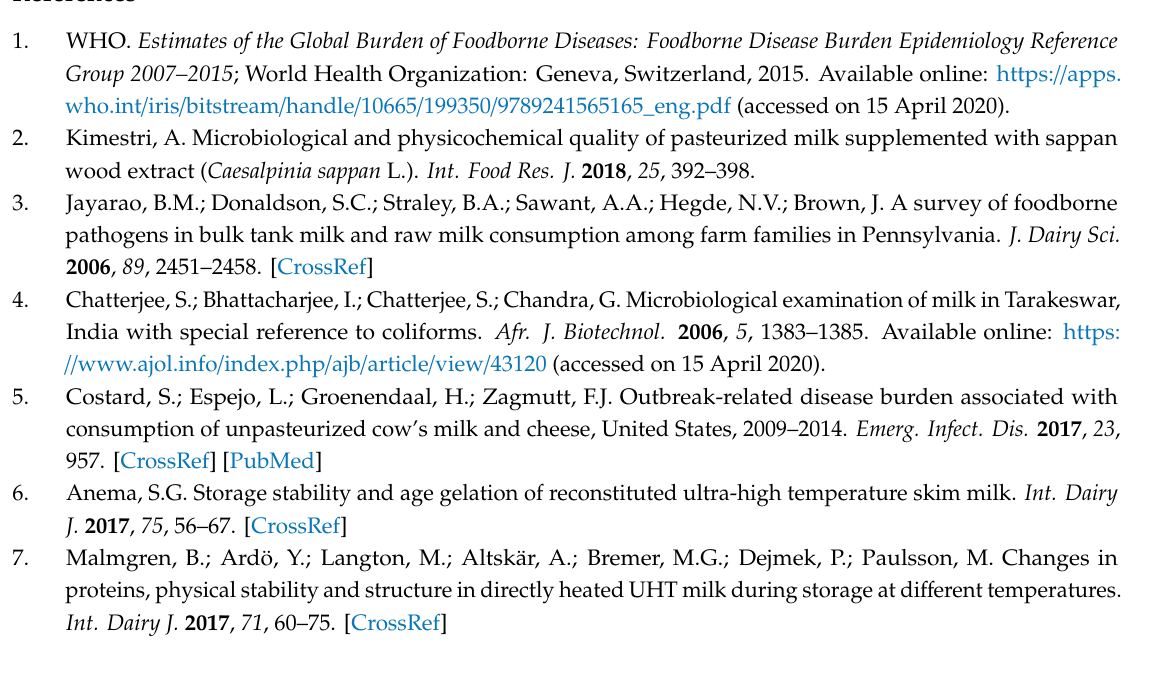
Table S1: The characteristics and performances of the calibration curves of the individual reference